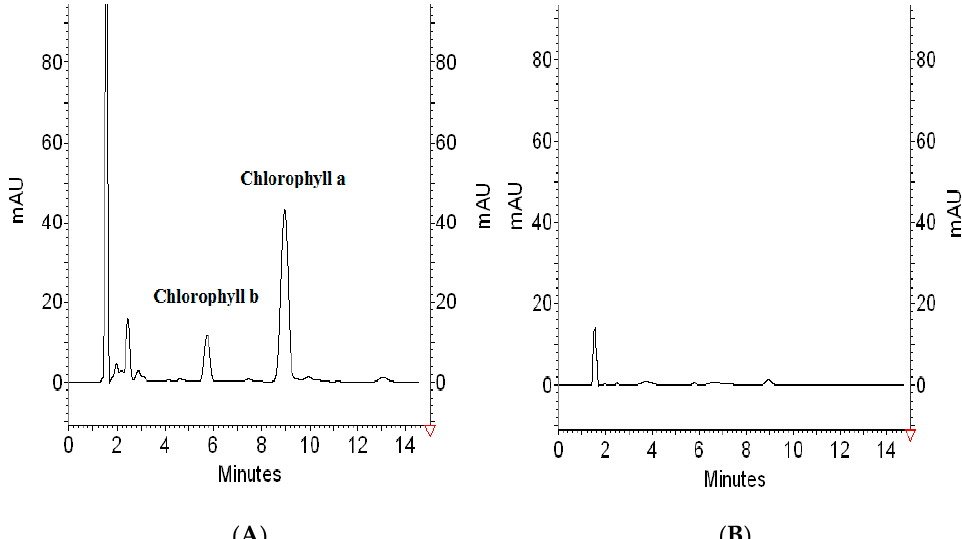
Figure 7. Chromatograms of the supernatants obtained from PVC (0.6 g) treated by 0.5 mL extract + 1.5 mL acetone + 1 mL water Figure 1 h, after elution by the use of 3 mL acetone ( A ), or methanol ( B ).